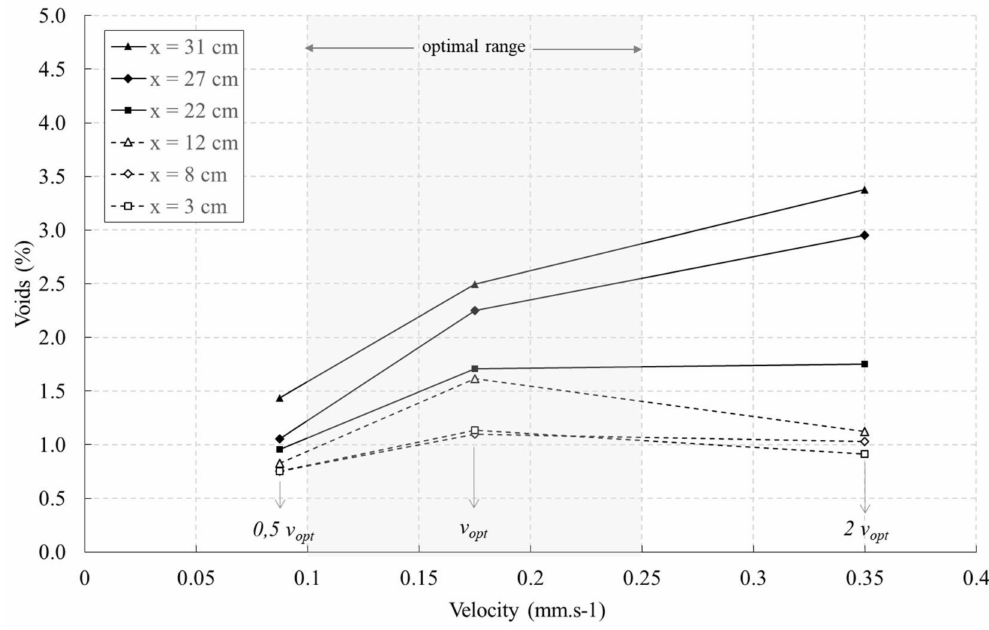
Figure 14. Measured void content as a function of injection velocity and distance from